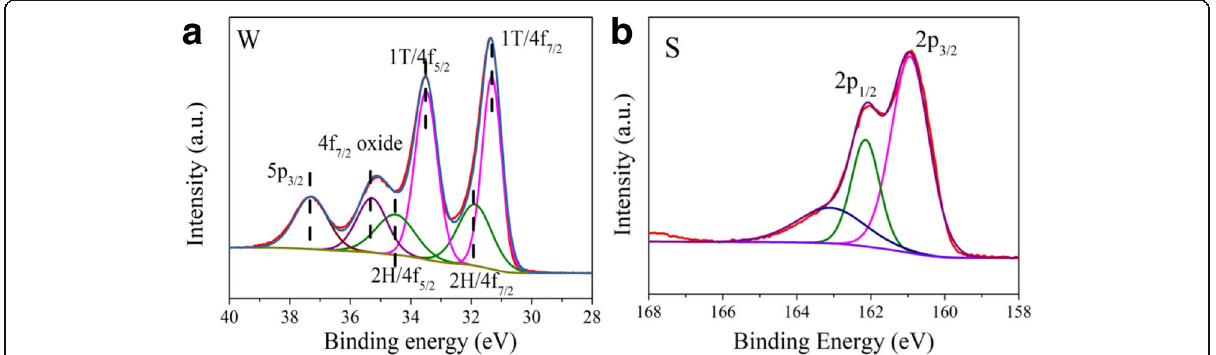
Fig. 4 XPS spectra of W 4f ( a ) and S 2p ( b ) binding energy of vertical 1T-WS 2 nanosheets